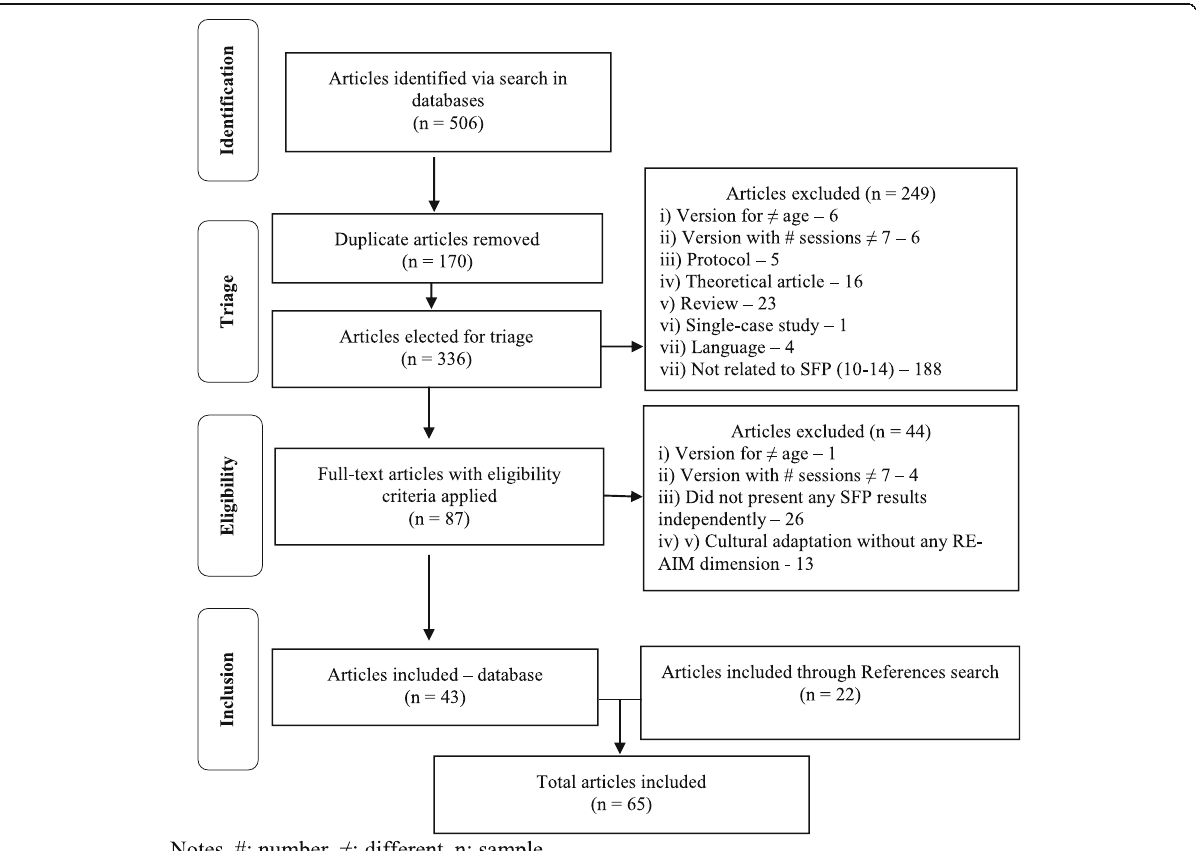
Fig. 1 Selection steps to compose the basis of the document. #: number. ≠ : different. n: